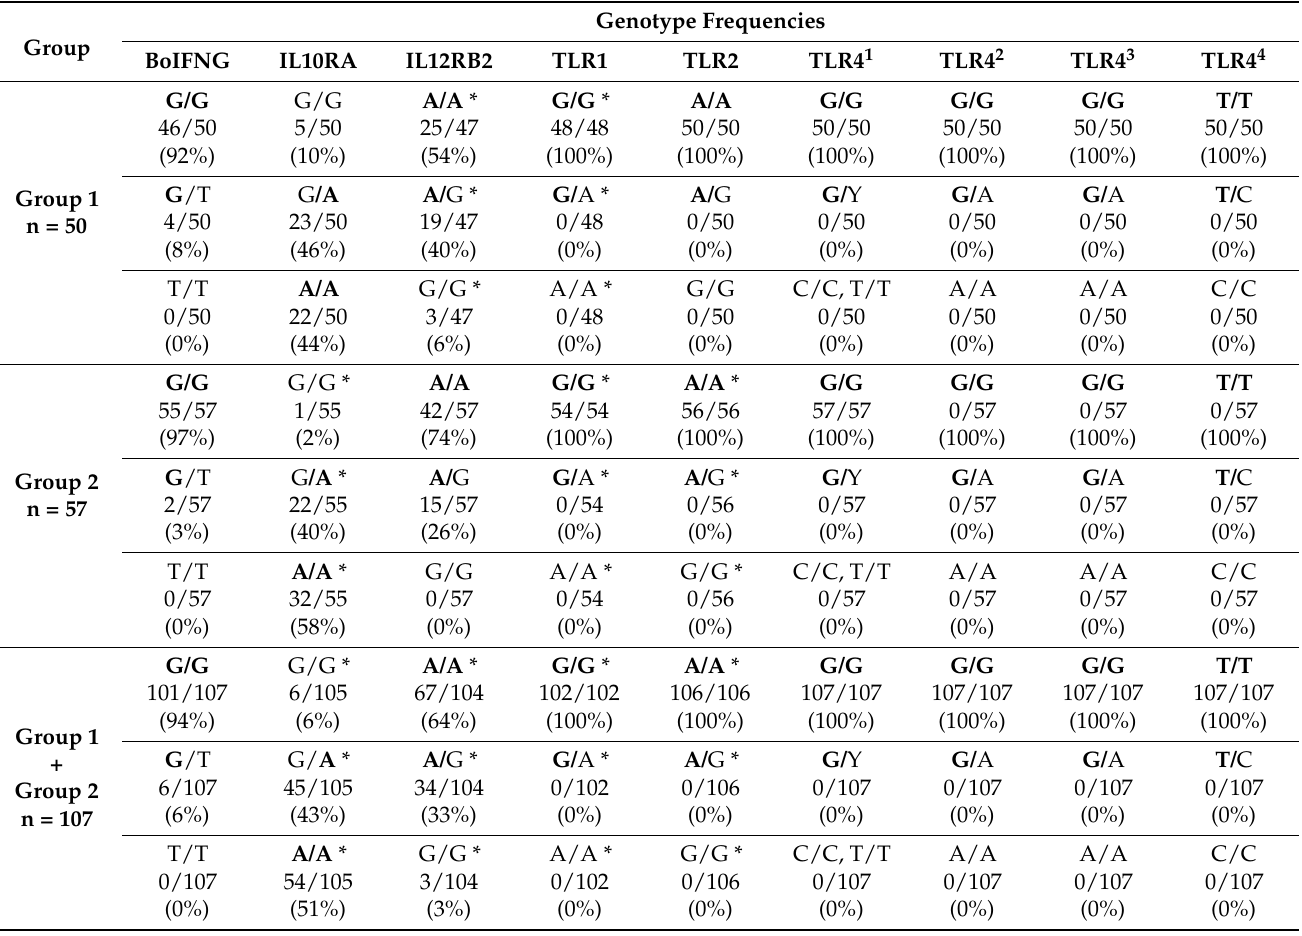
Table 2. Genotype frequencies of each single nucleotide polymorphism (SNP) for candidate tar- get